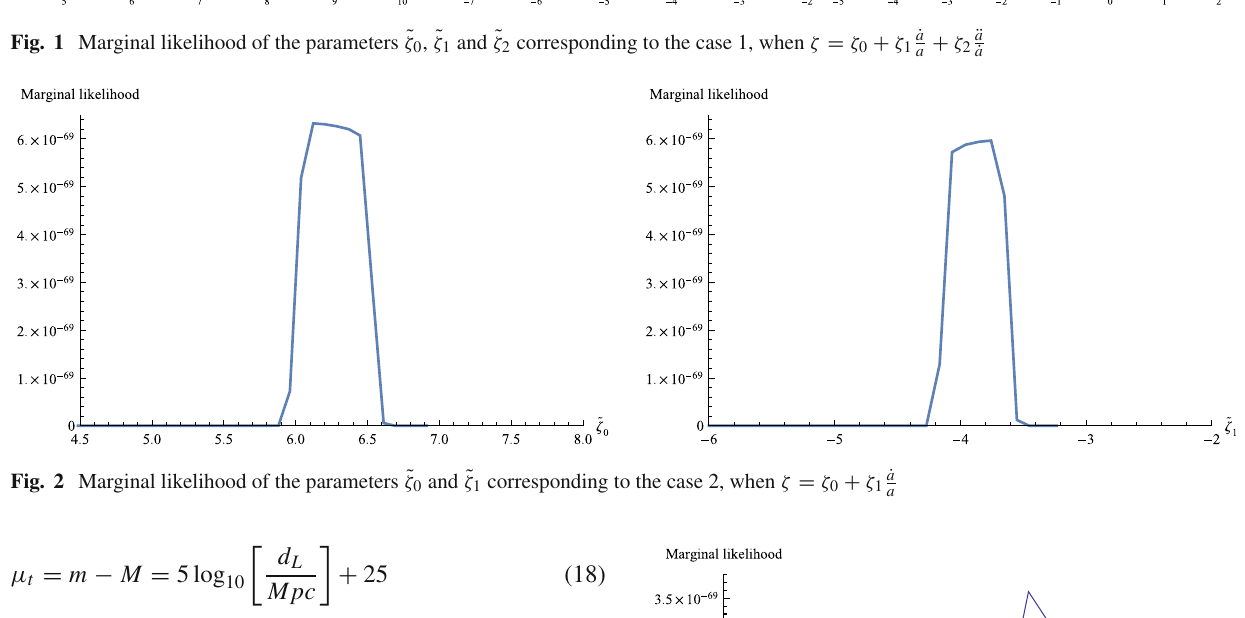
Fig. 1 Marginal likelihood of the parameters ˜ ζ 0 , ˜ ζ 1 and ˜ ζ 2 corresponding to the case 1, when ζ = ζ 0 + ζ 1 ˙ a